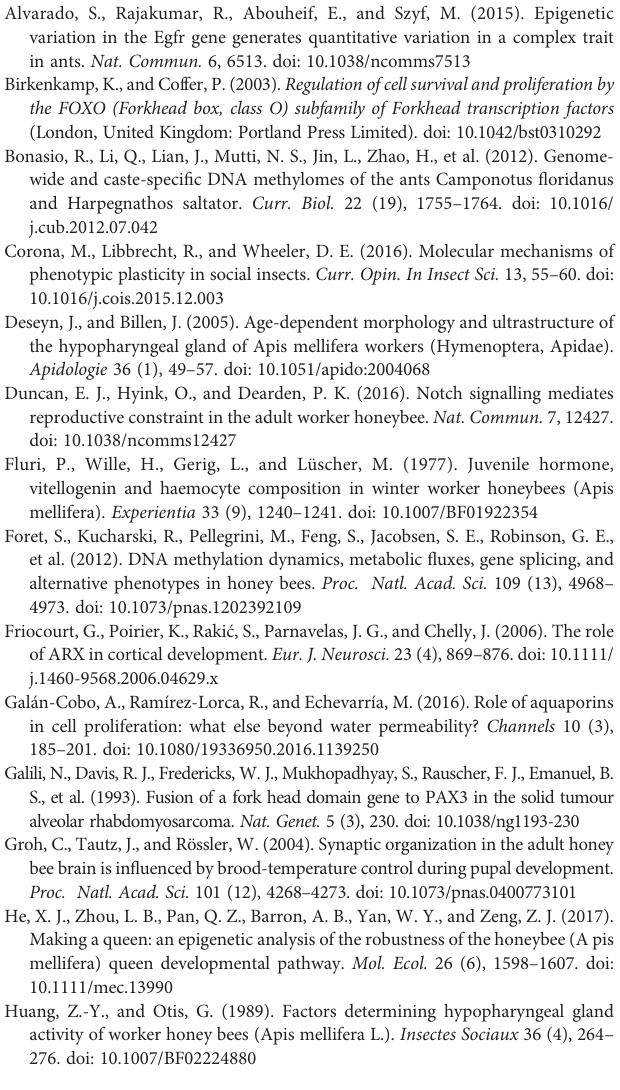
represent mCG, mCHG, and mCHH respectively. This picture shows relationship between methylation levels and percentage of total mC. FIGURE S2 | Relationship between sequence context and methylation preference. WB, Winter Bee. SB, Spring Bee. The abscissa represents all possible 9-mer sequences where the mC was in the fourth position and the ordinate represents the percentage of bases. FIGURE S3 | The methylation levels of CHH type in various functional regionsThe trendofmCHHtypedistributionacrossdifferentfunctionalregions.WB,WinterBee; SB, Spring Bee. The abscissa represents the different regions of gene functional elements. The dotted green line denotes the transcriptional start site. The ordinate represents the methylation levels of mCHH. FIGURE S4 | The methylation levels of CHG type in various functional regionsThe trend of mCHG type distribution across different functional regions. WB, Winter Bee; SB, Spring Bee. The abscissa represents the different regions of gene functional elements. The dotted green line denotes the transcriptional start site. The ordinate represents the methylation levels of